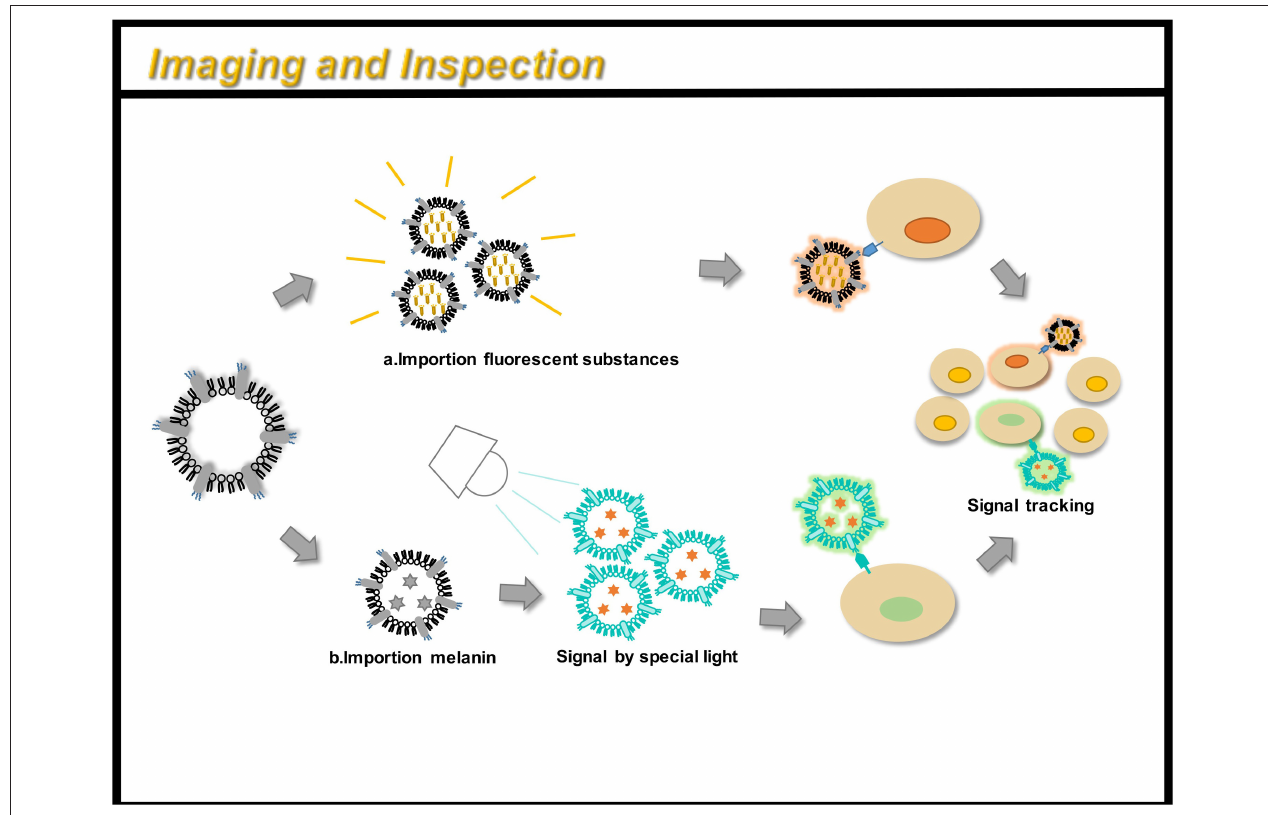
FIGURE 5 | OMVs can be engineered for immunoimaging and cell detection. There are two main methods: (a) directly loading a fluorescent substance; (b) indirectly loading a small molecular substance (such as melanin), and a signal can be obtained under a specific light. By taking OMV preparation, you can track the path of action of the drug in the body and monitor its